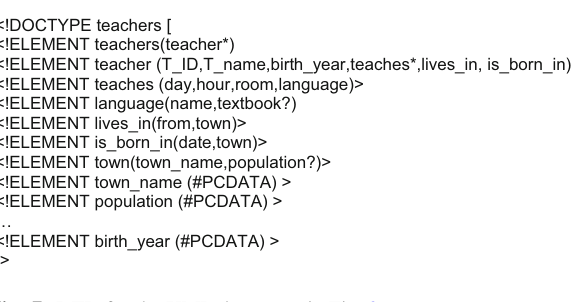
Fig. 7 DTD for the XML document in Fig.